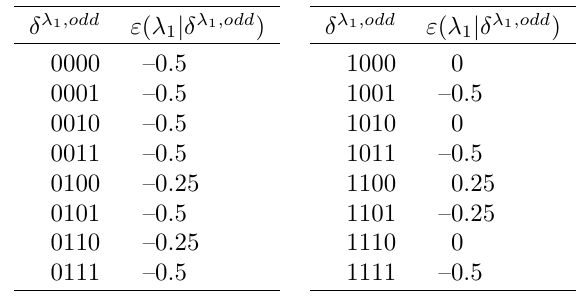
Table 5: The Biases of Single-Round Conditional Linear